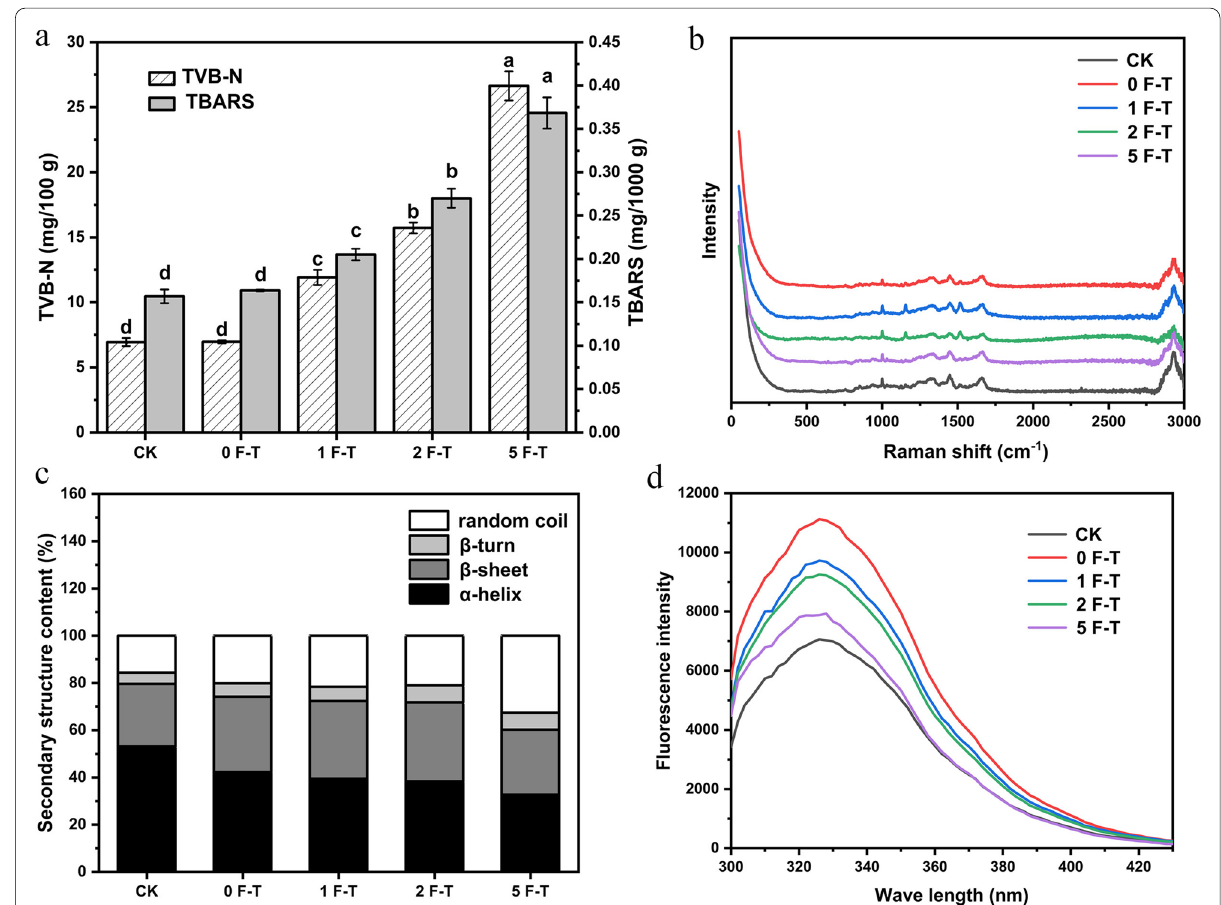
Fig. 2 Effect of repeated freeze thaw cycles on the TVB-N and TBARS values of cooked crayfish ( a ), Raman spectra of MPs of cooked crayfish during repeated freeze-thaw cycles ( b ), changes in the secondary structure of cooked crayfish after repeated freeze-thaw cycles ( c ), and endogenous fluorescence spectra of MPs after repeated freeze-thaw cycles ( d ) (CK: fresh crayfish; 0 F-T: cooked crayfish with 0 freeze-thaw cycles; 1 F-T: cooked crayfish with 1 freeze-thaw cycle; 2 F-T: cooked crayfish with 2 freeze-thaw cycles; 5 F-T: cooked crayfish with 5 freeze-thaw cycles). Different letters in the same column of the same indicator showed significant difference ( p < 0.05